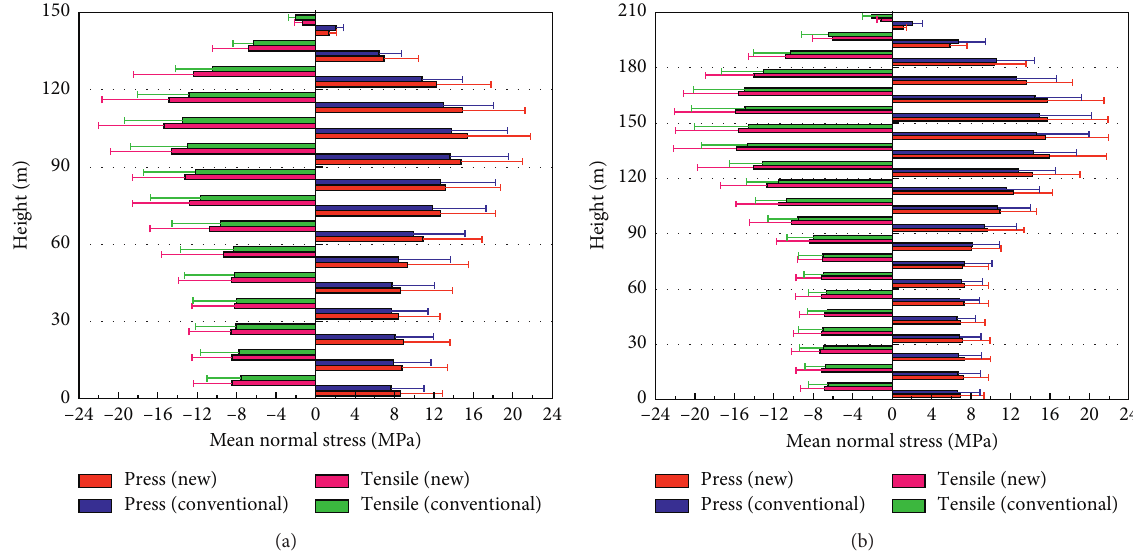
Figure 9: Comparisons of mean and standard deviation of the normal stress of chimney: (a) 150m high chimney; (b) 210m high chimney. Table 7: Maximum earthquake tensile stresses of the 150m high chimney considering vertical eccentricities. High